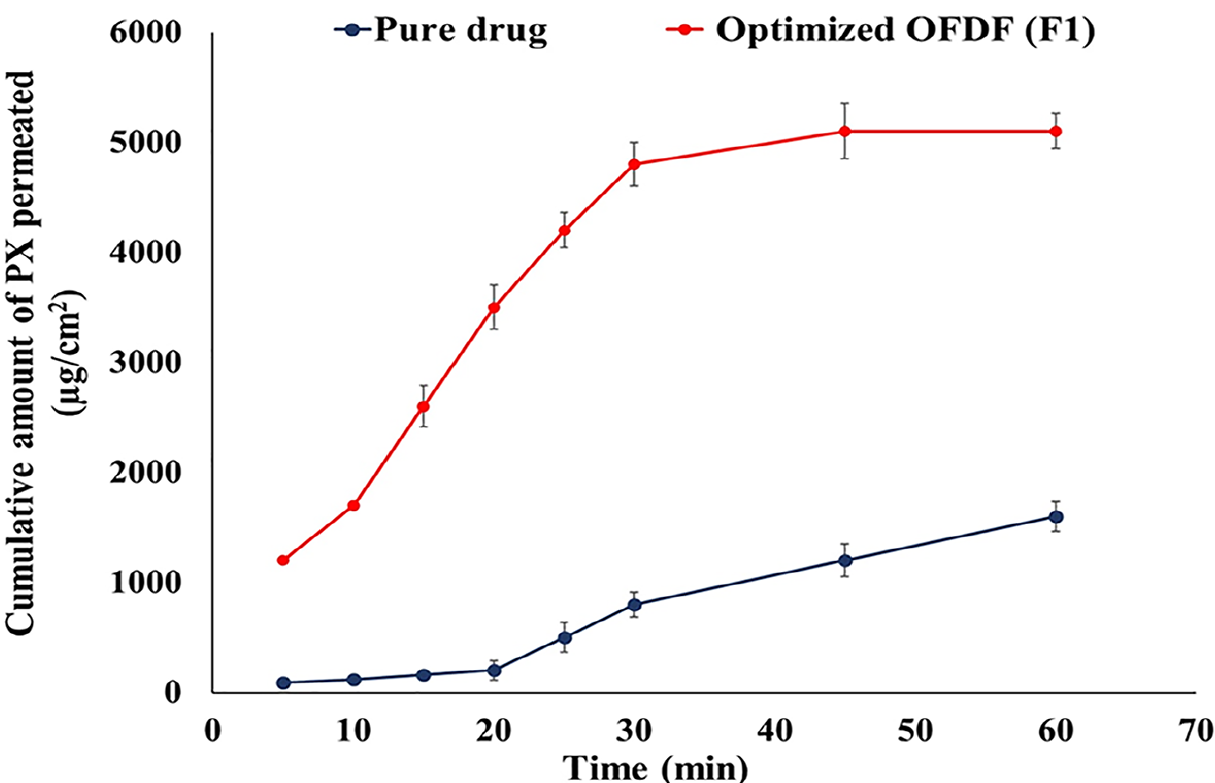
Figure 6. Permeation profiles of PX from the optimized OFDF (F1) and the pure drug through the chicken buccal mucosa.